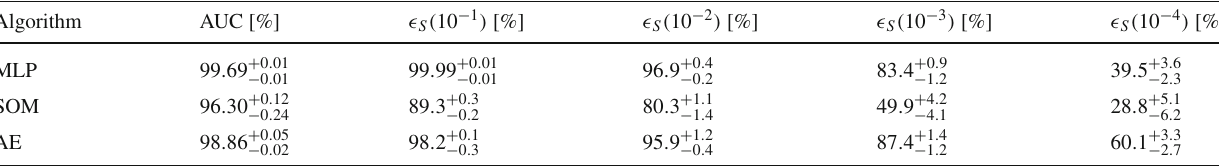
Table 4 Performance metrics of the investigated machine learning techniques for the evaluation set